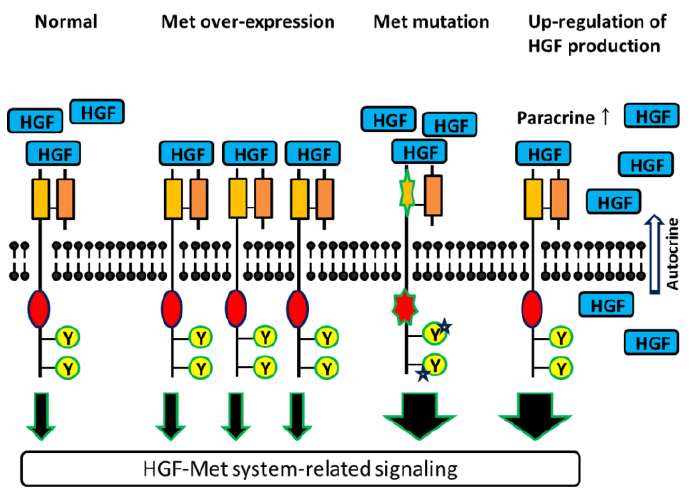
Figure 1. In cancer, HGF-Met signaling is up-regulated by various systems, including over-expression or mutation of Met and increased HGF production.